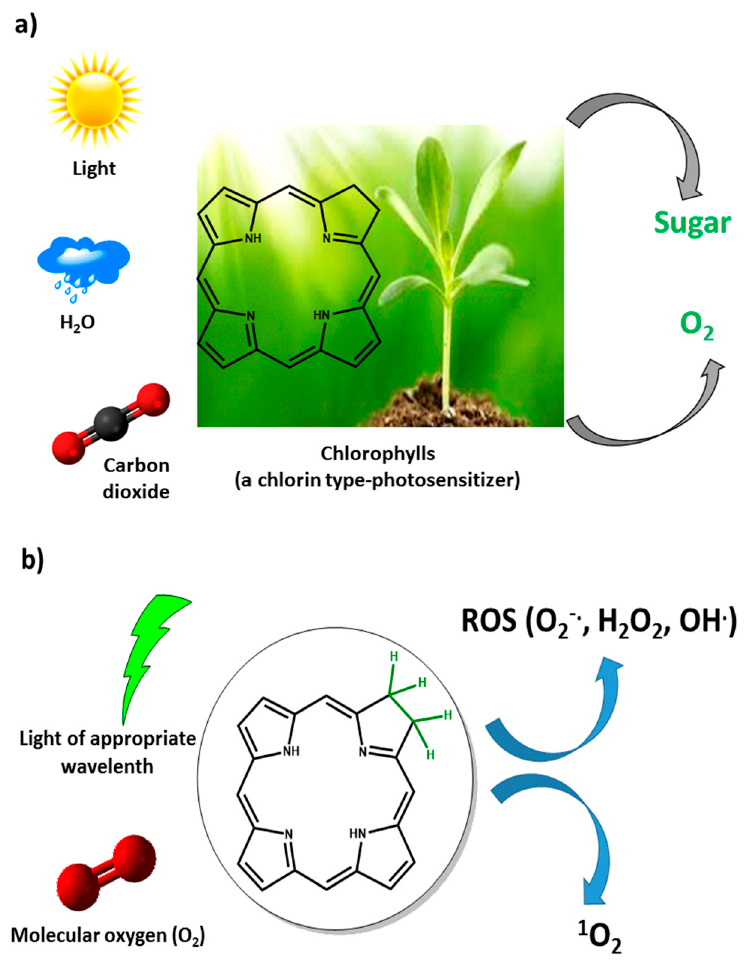
Figure 1. ( a ) General photosynthesis process; ( b ) Representation of a simple photodynamic therapy protocol. ROS: reactive oxygen species.